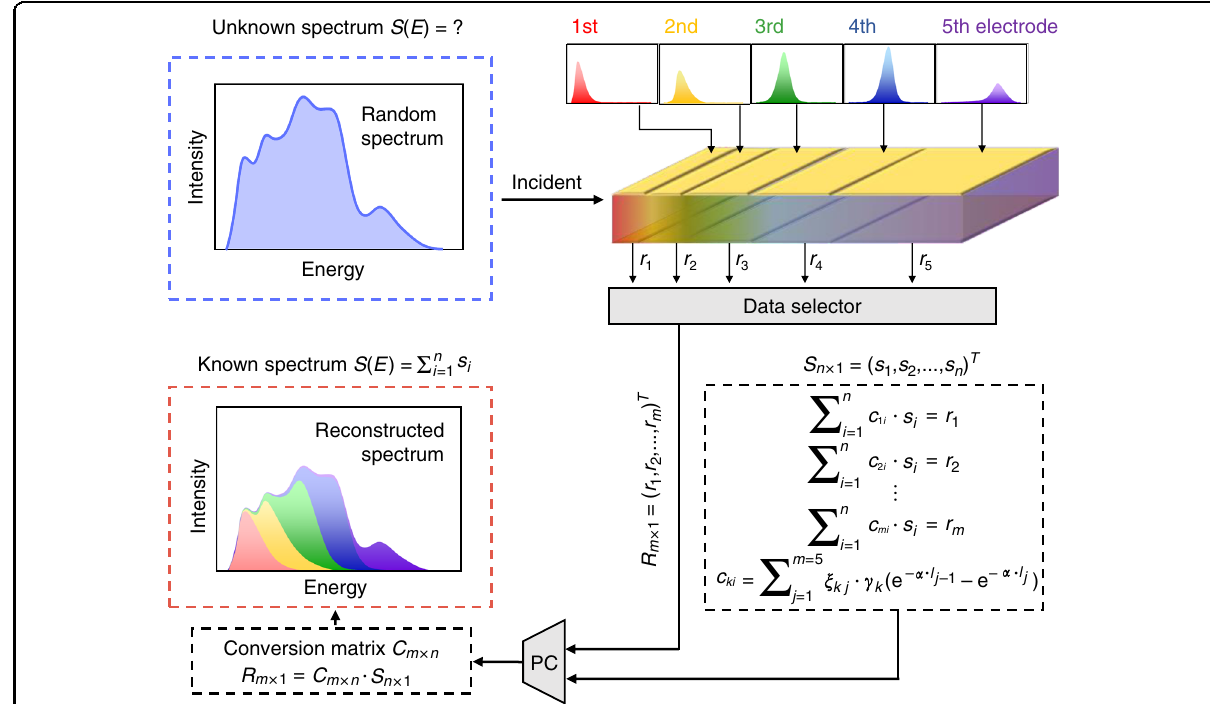
Fig. 1 The schematic illustration of the working principle of multi-energy X-ray